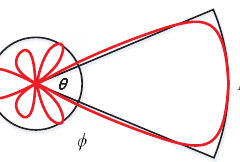
Figure 2. A sectored model to approximate the beamforming